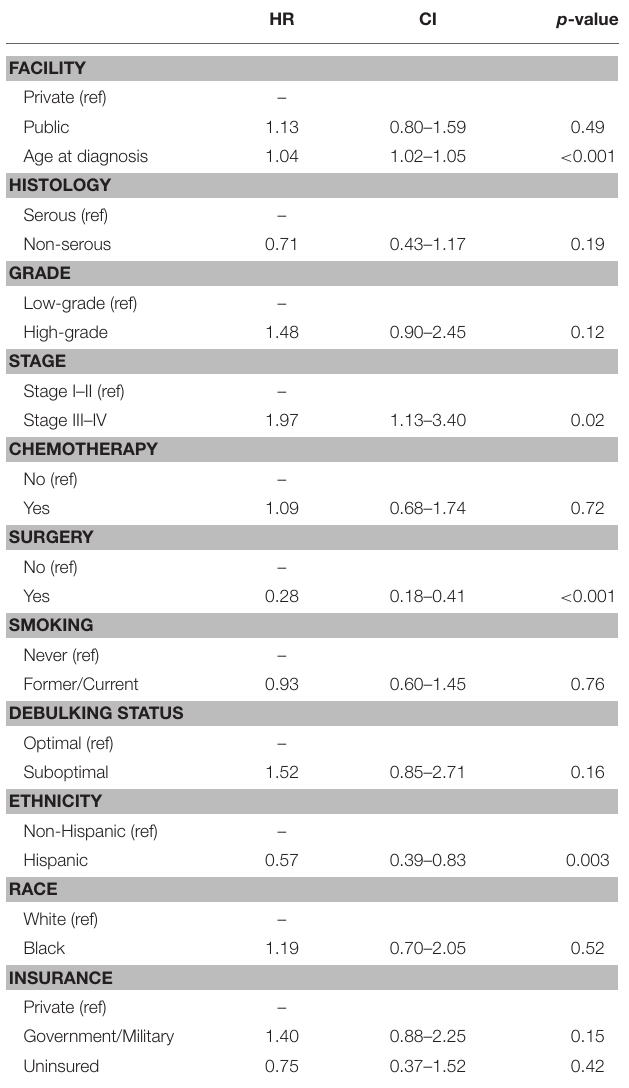
TABLE 4 | Cox proportional hazards modeling of overall survival among Caribbean-born women with ovarian cancer. HR CI p -value